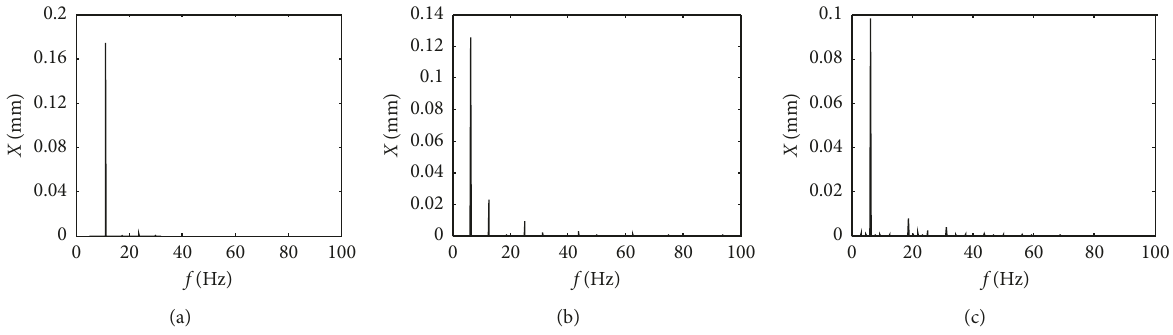
0.2mm. (b) j (cid:29)